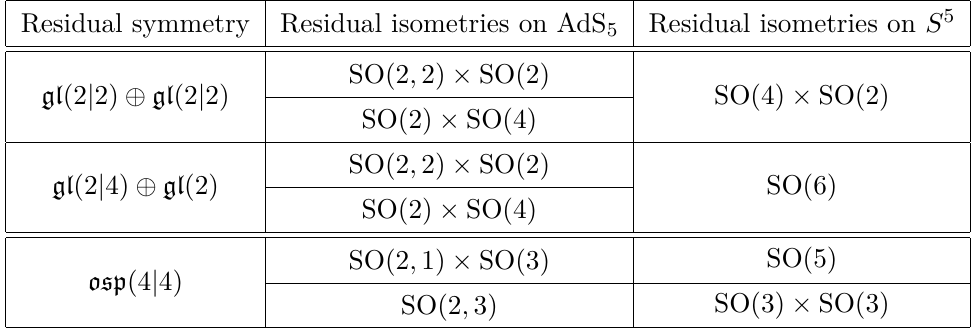
Table 5 . Possible crosscaps in the AdS 5 / CFT 4